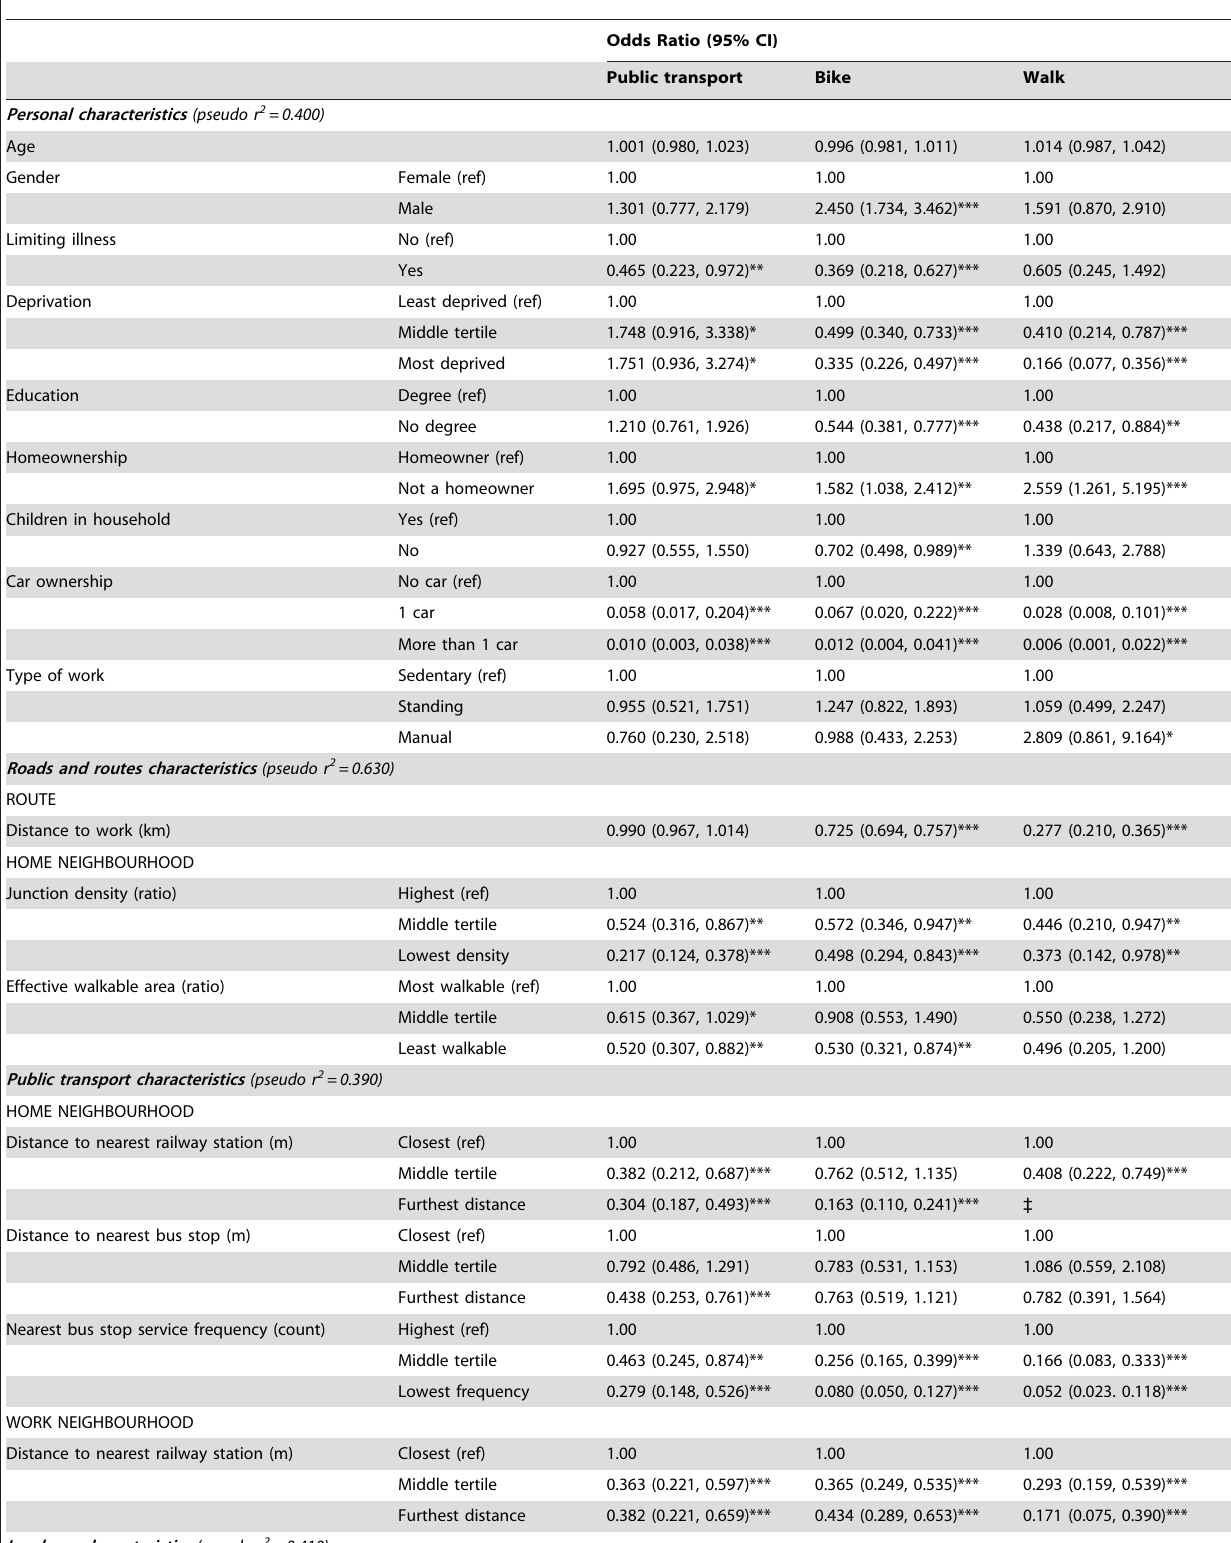
Table 2. Univariate associations between personal and environmental characteristics and main mode of travel to work (reference category is